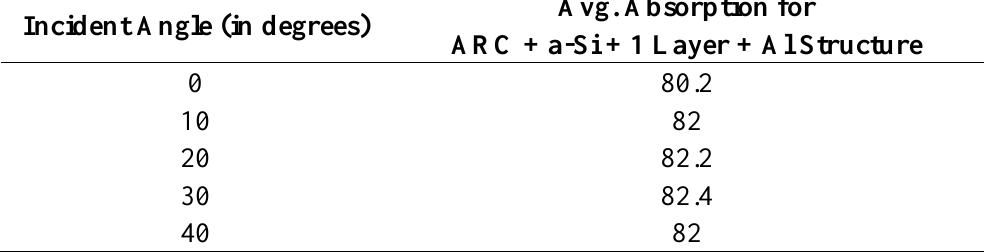
Table 7. Study of the performance of the structure with an AR coating, 1 Layer DBR and an aluminum layer, at different angles of